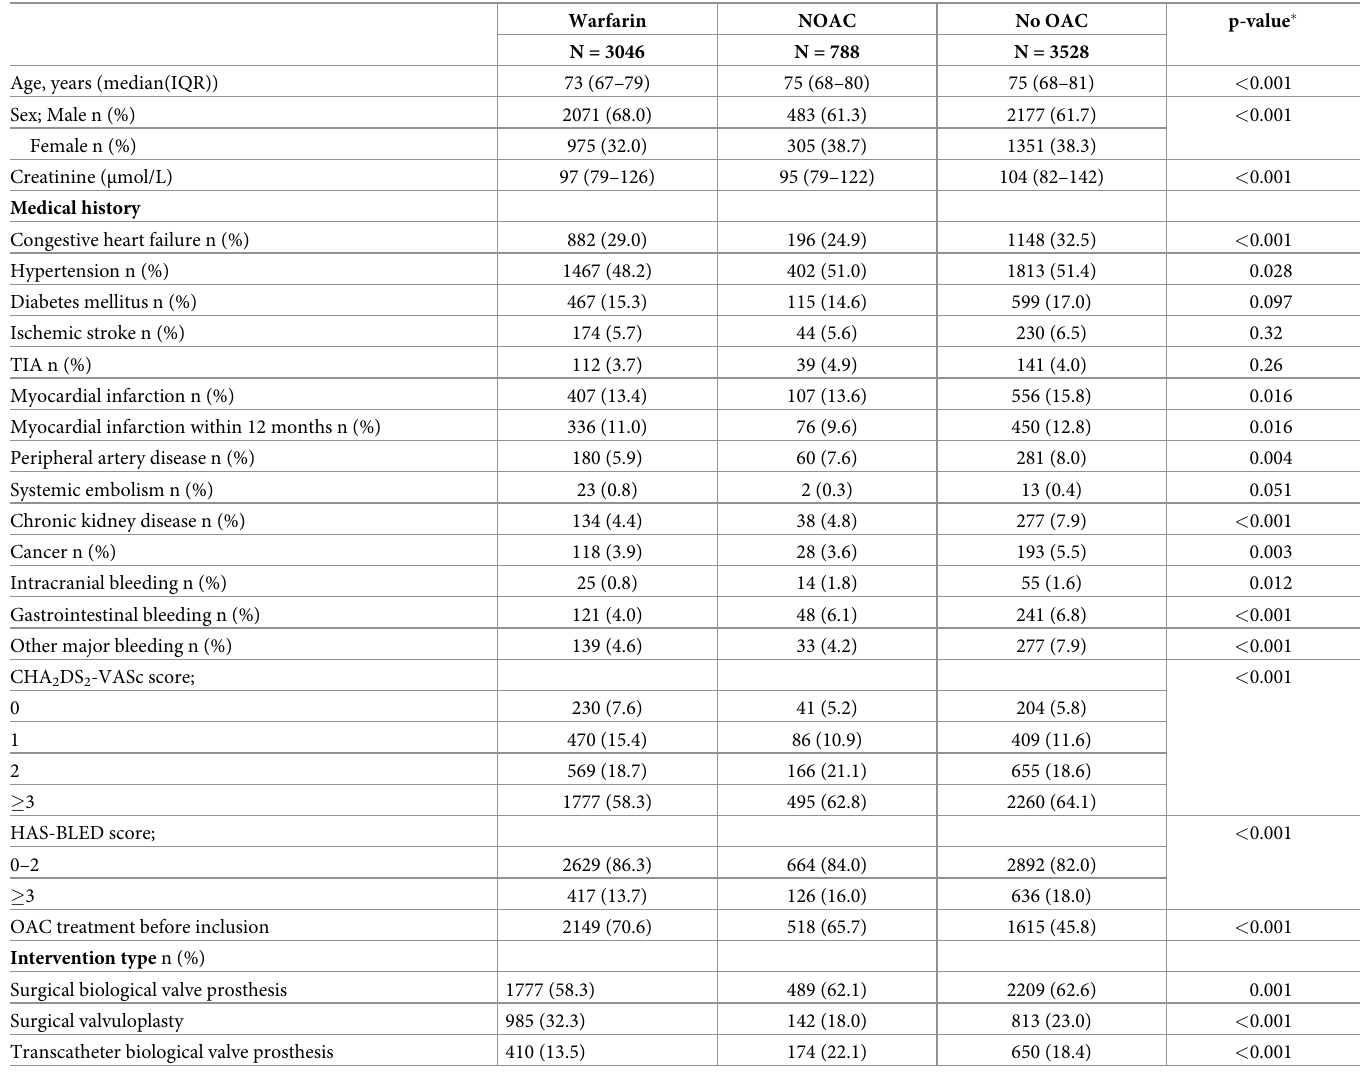
Table 3. Clinical characteristics and oral anticoagulant treatment.